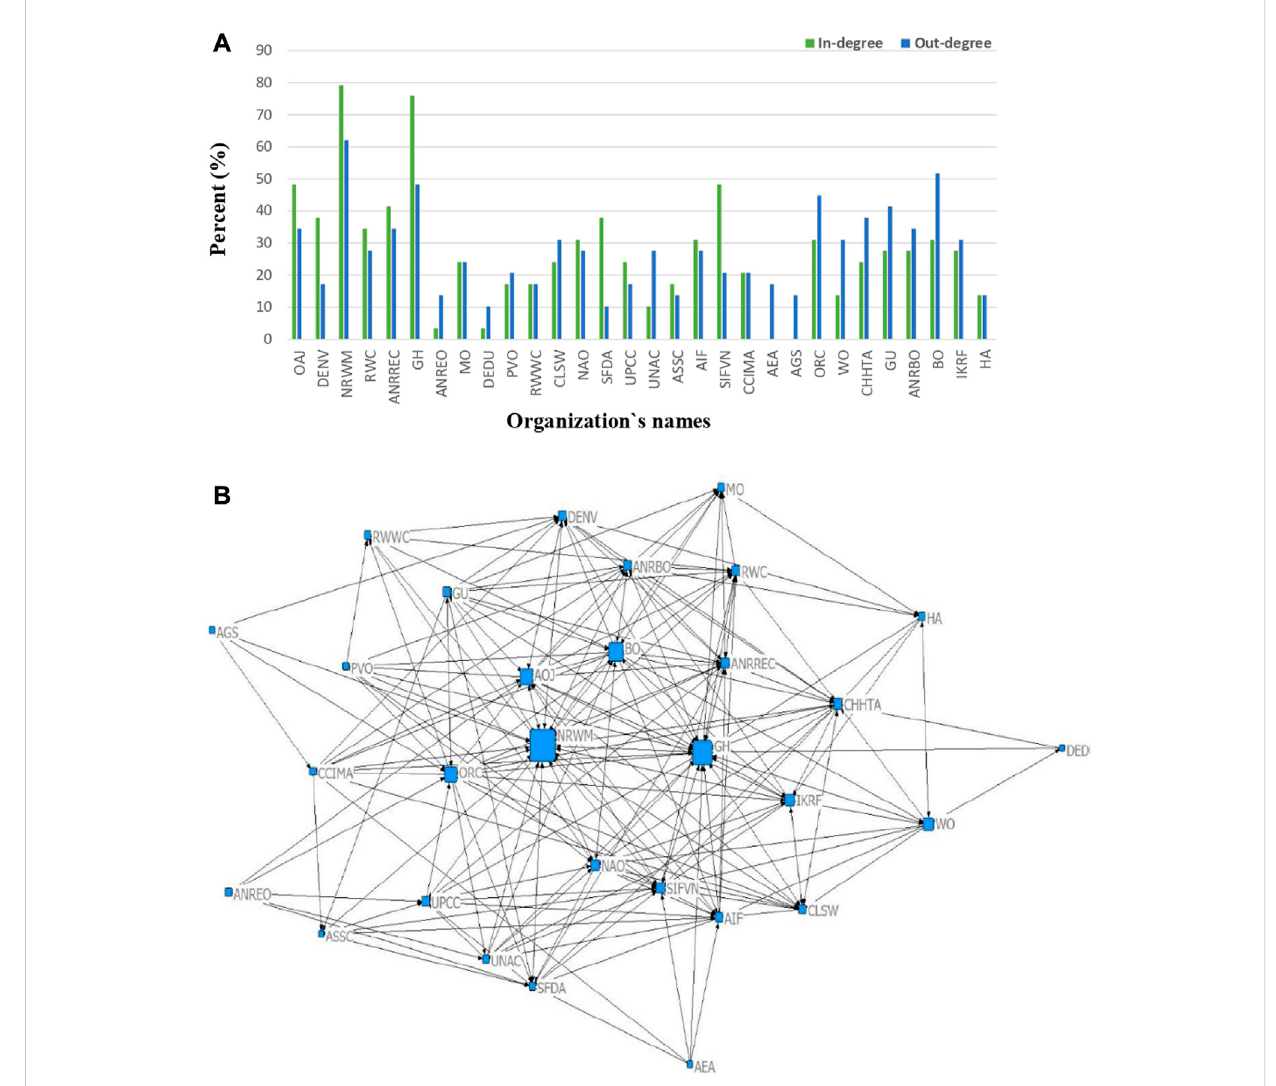
FIGURE 3 SNA results of the coordination network. (A) In-degree and out-degree centrality. (B) Between centrality ( Larger size indicates higher between centrality